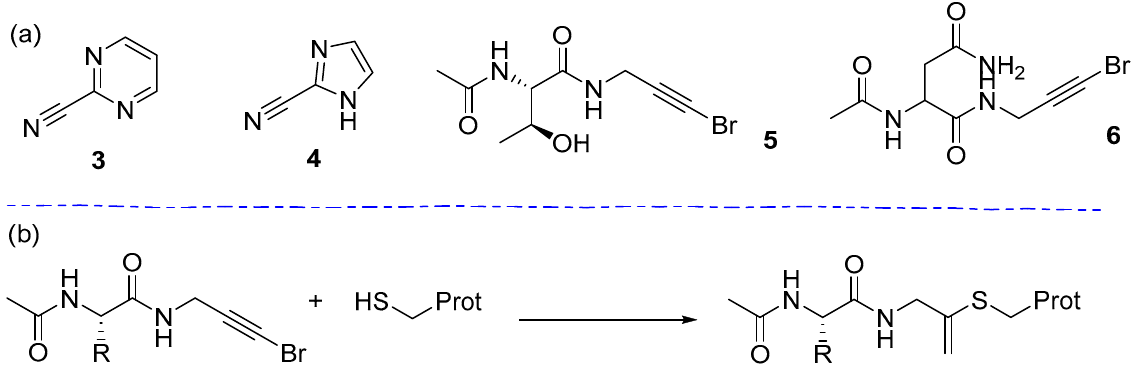
Figure 4. ( a ) Covalent fragment binders of Sars-Cov2 main protease; ( b ) Reaction scheme of covalent modification to Cys145 by 3-bromoprop-2-yn-1-yl amides.